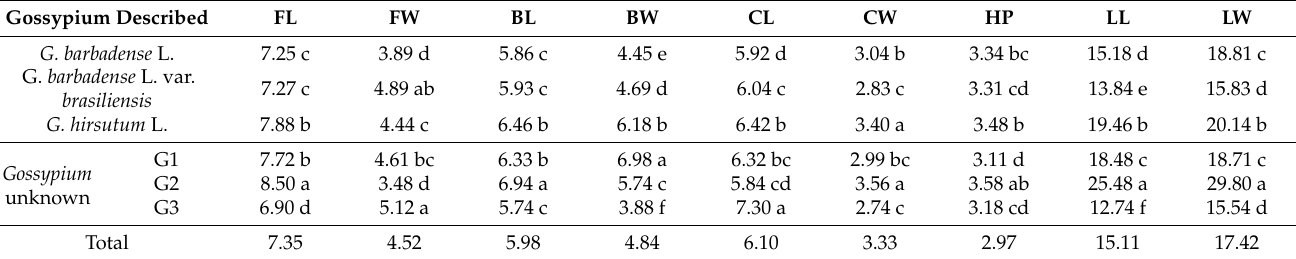
Table 3. Comparison of means of quantitative descriptors obtained when characterizing species of Gossypium spp. collected in the province of La Convenci ó n, in the districts of Echatari and Megantoni,